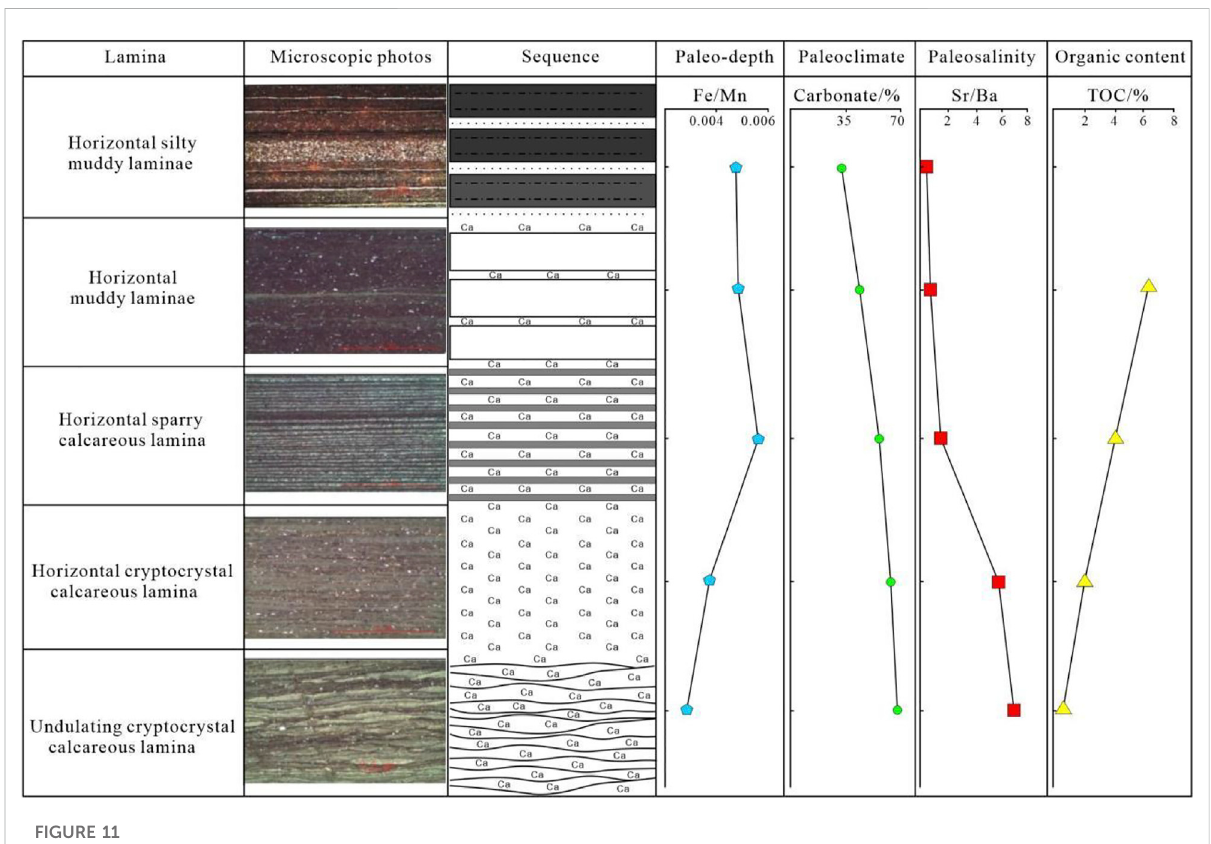
FIGURE 11 Plot of salinity and layer